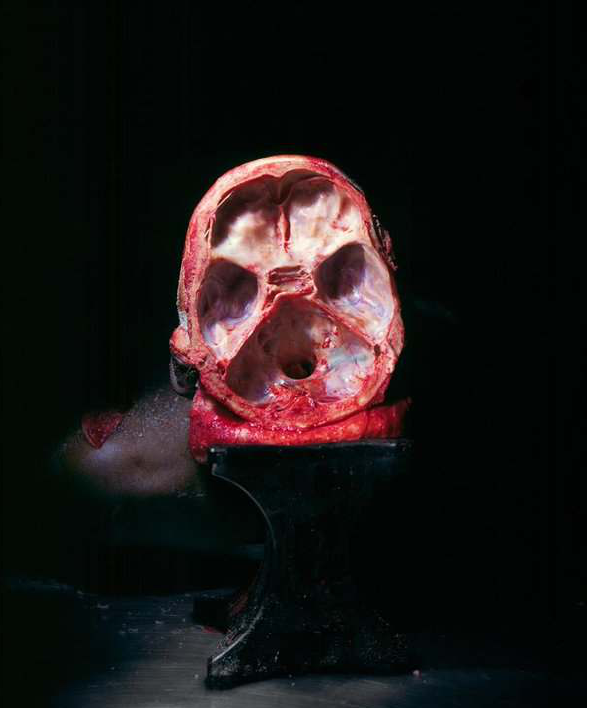
Source: https://aguilerahellweg.com/the-sacred-heart-an-atlas-to-the-body-seen-through-invasive- surgery/jjfdg8zli9vhgn0rtxyydtle0dwza9. All rights